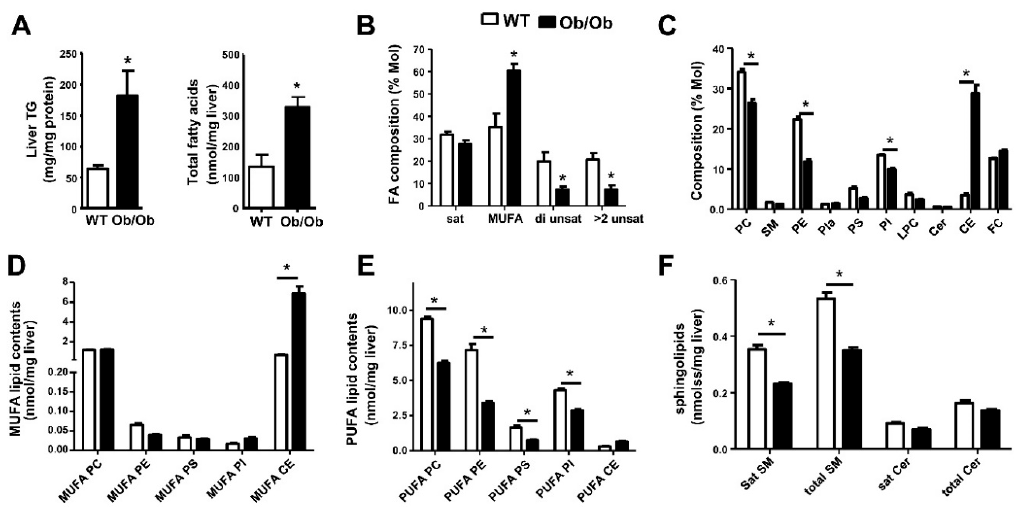
Figure 1. Lipid contents and composition show a defect of hepatic PL remodeling in Ob / Ob mice. Male wild-type (WT) and Ob / Ob mice at six months old were used. ( A ) The contents of hepatic triglycerides (TG), total fatty acids (FAs). ( B ) FA composition of saturated, monounsaturated fatty acids (MUFA), di unsaturated, and > 2 unsaturated FA. ( C ) The composition of phospholipids (PLs) and cholesterol esters (CEs). ( D ) The contents of PLs and CEs containing monounsaturated fatty acids (MUFA). ( E ) The contents of PLs and CEs containing polyunsaturated fatty acids (PUFA). ( F ) The contents of sphingolipids. Data are mean ± SEM, N = 5–7; *, p < 0.05 versus WT.